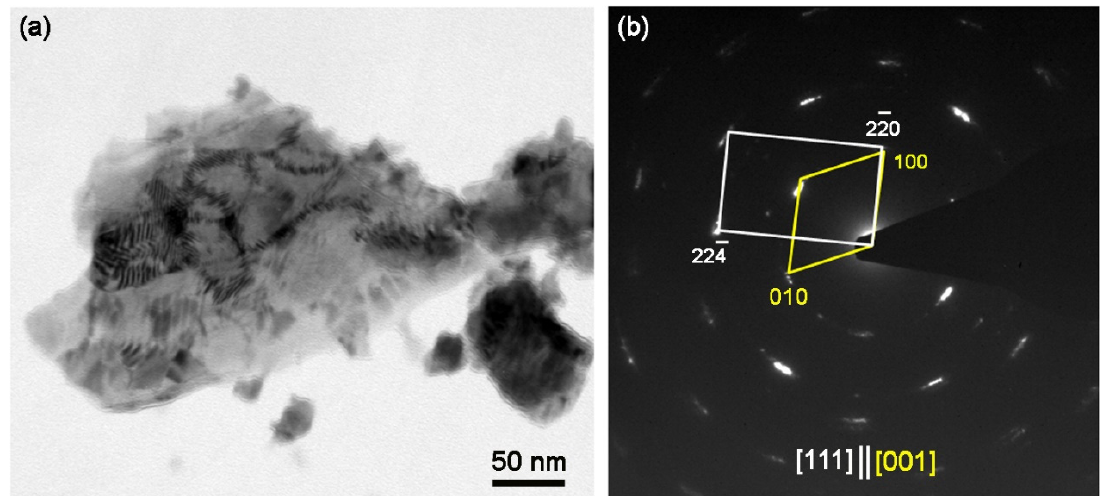
Figure 3. ( a ) TEM image of (CuCr 2 Se 4 ) 0.4 (CuCrSe 2 ) 0.6 sample. Clear Moire fringes suggest that there is overlap of two phases. ( b ) Selected area electron diffraction pattern of (CuCr 2 Se 4 ) 0.4 (CuCrSe 2 ) 0.6 sample. Yellow lozenge shows the SAED pattern from the CuCrSe 2 phase, while white rectangle does from the CuCr 2 Se 4 one. The orientation relationship between CuCrSe 2 and CuCr 2 Se 4 is determined as [001] (100) ‖ [111] (220). The broadening of reflection spots come from two phases and small misorientation of CuCrSe 2 layers.